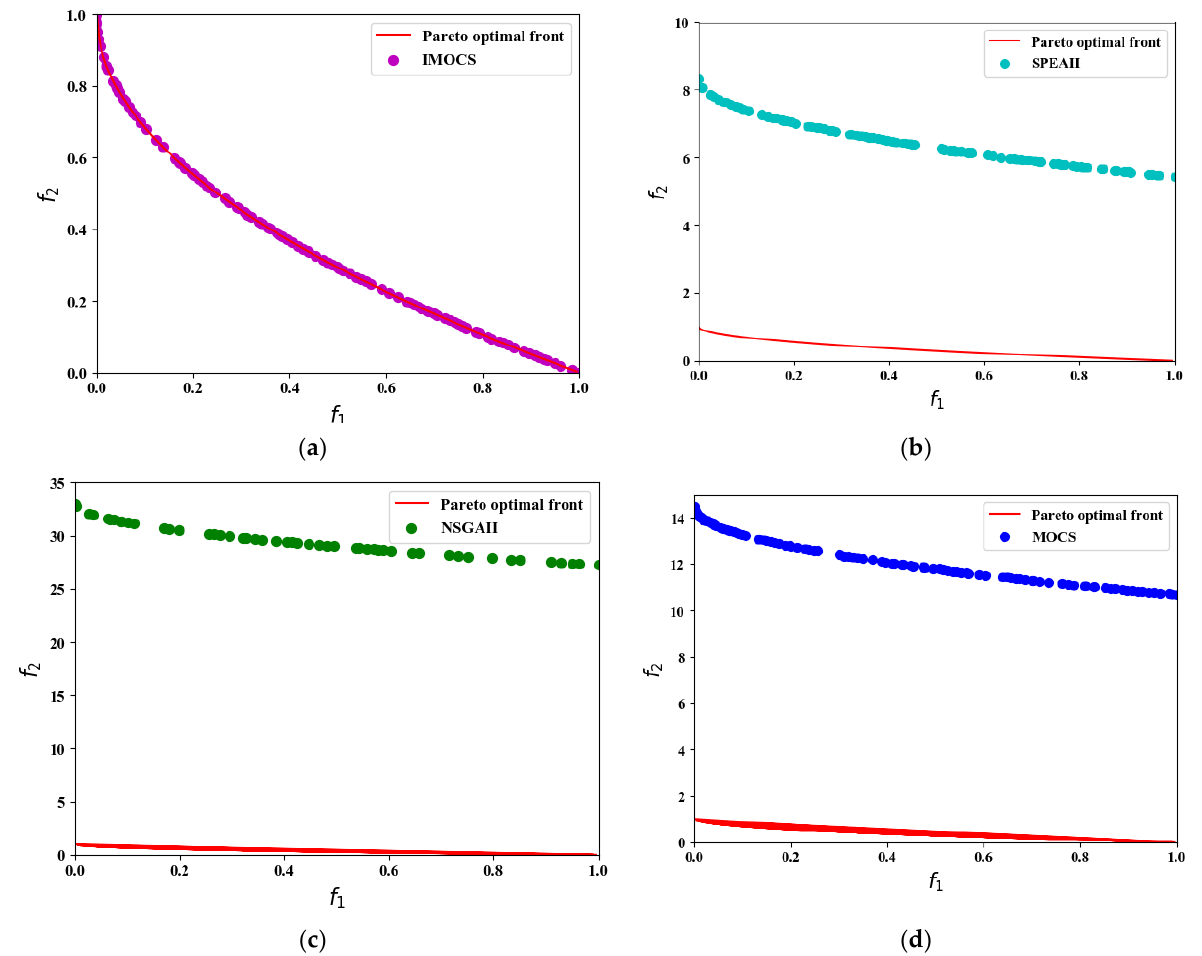
Figure 5. The convergence results of ZDT4 test problem over all algorithms. ( a ) IMOCS, ( b ) SPEAII,